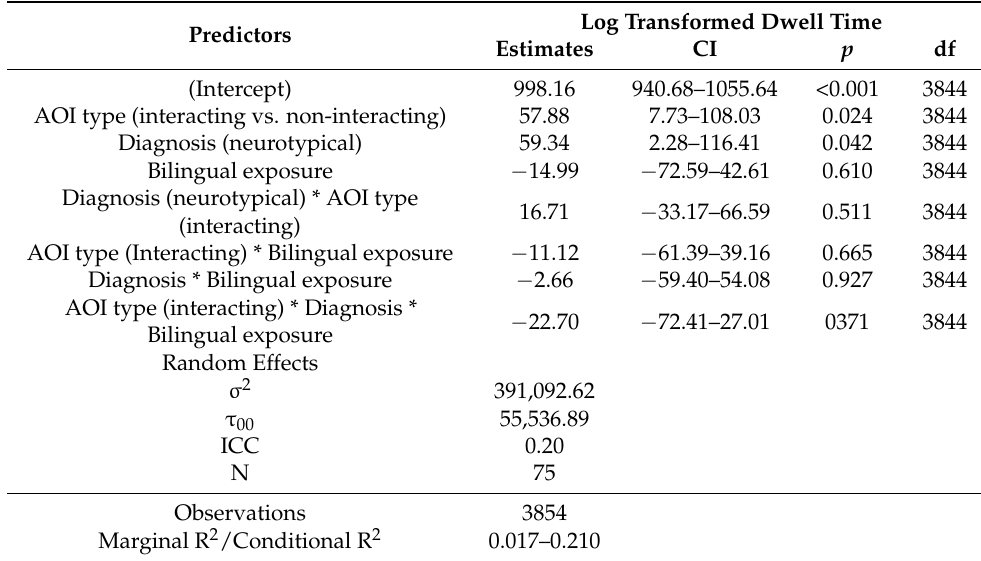
Table 4. Fixed and random effects as a summary of the linear mixed model with bilingual exposure for the whole-figure AOIs. The conditional R 2 accounts for the variance explained by the whole model, while the marginal R 2 accounts for the fixed effects only.